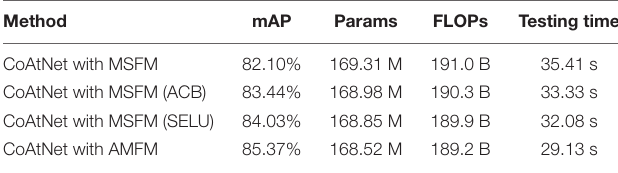
TABLE 11 | A single ablation experiment of asymmetric multi-scale fusion module